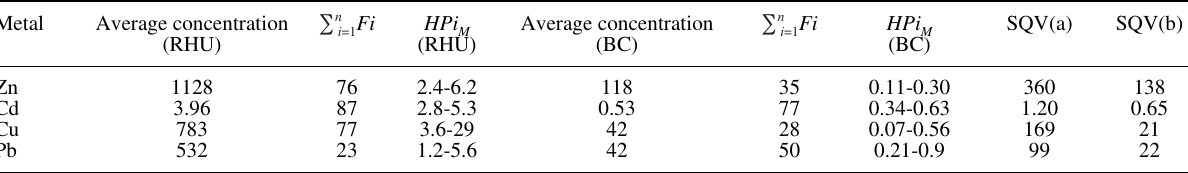
calculated using the M index shows M